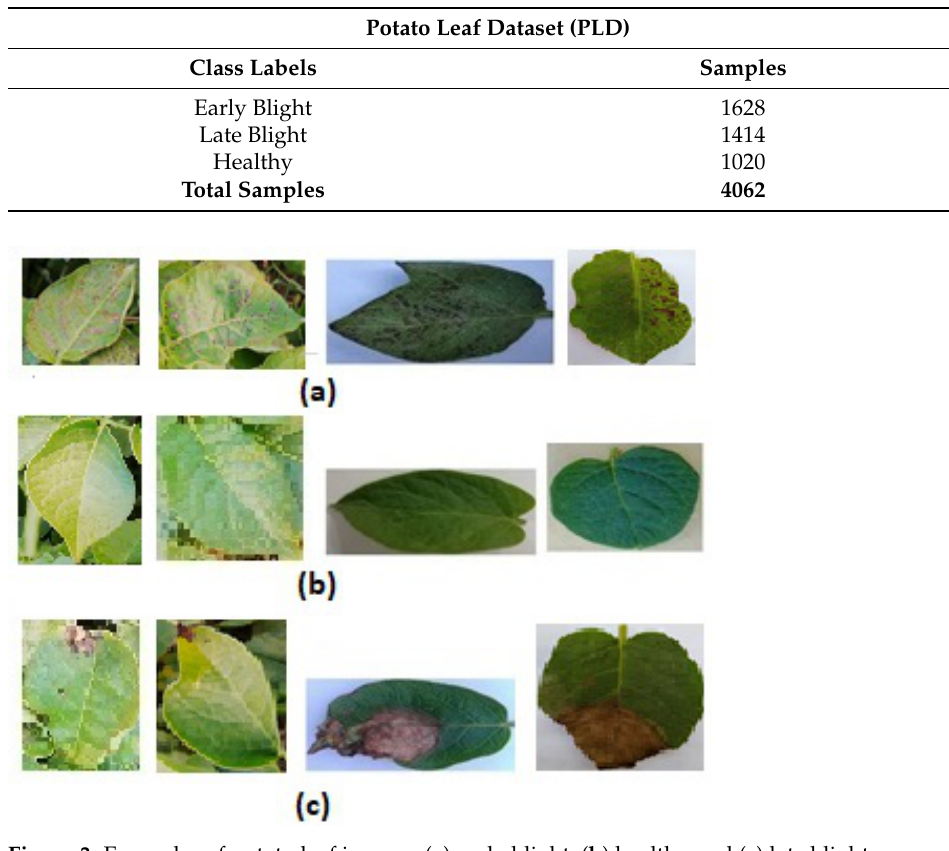
Figure 3. Examples of potato leaf images: ( a ) early blight, ( b ) healthy and ( c ) late